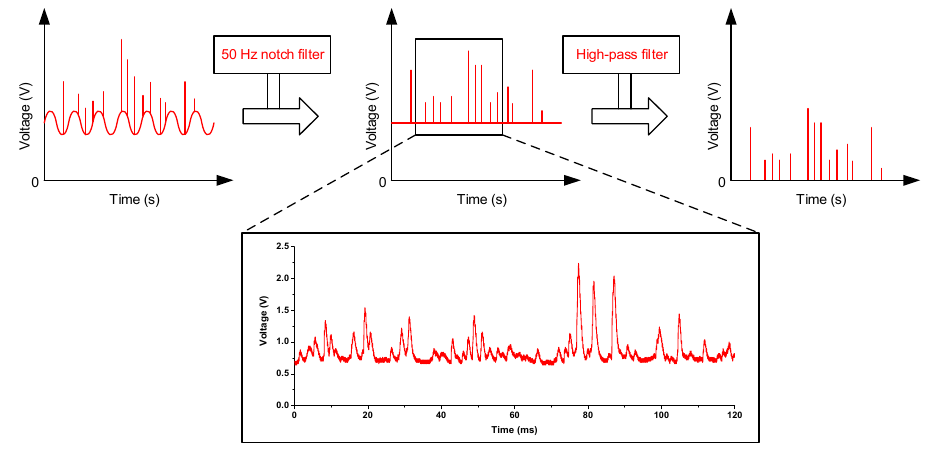
Figure 3. Signal processing steps.